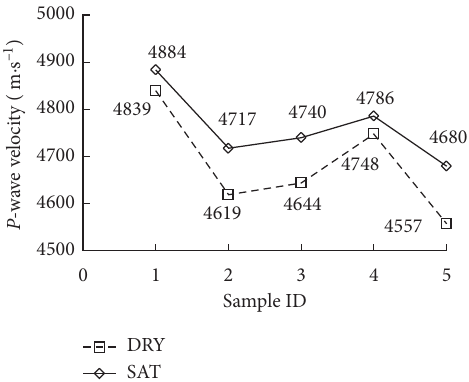
Figure 4: P -wave velocity test results of tuff in Mila Mountain tunnel under dry and saturated conditions.